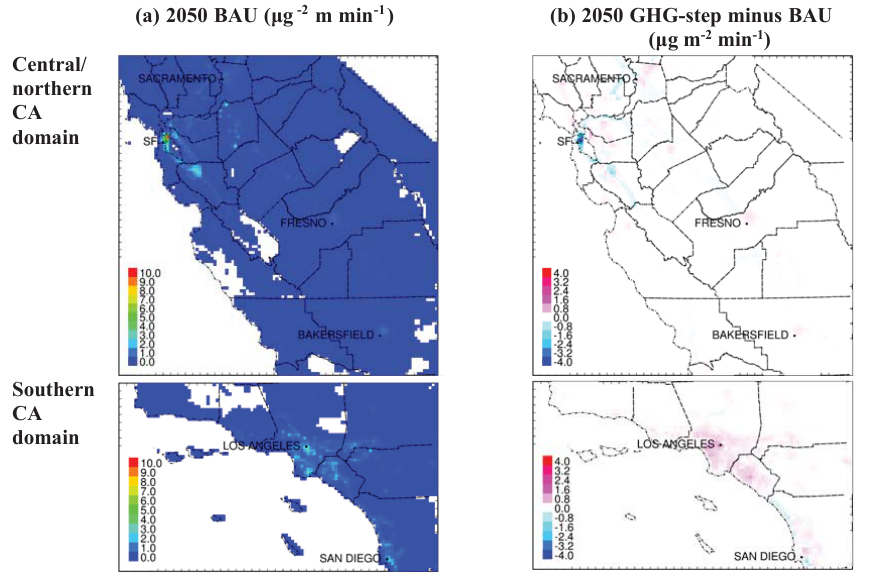
Figure 13. Particulate matter emissions from rail and other off-road sources in the BAU scenario (a) and emissions change in the GHG-Step scenario (b) . Units are µgm − 2 min − 1